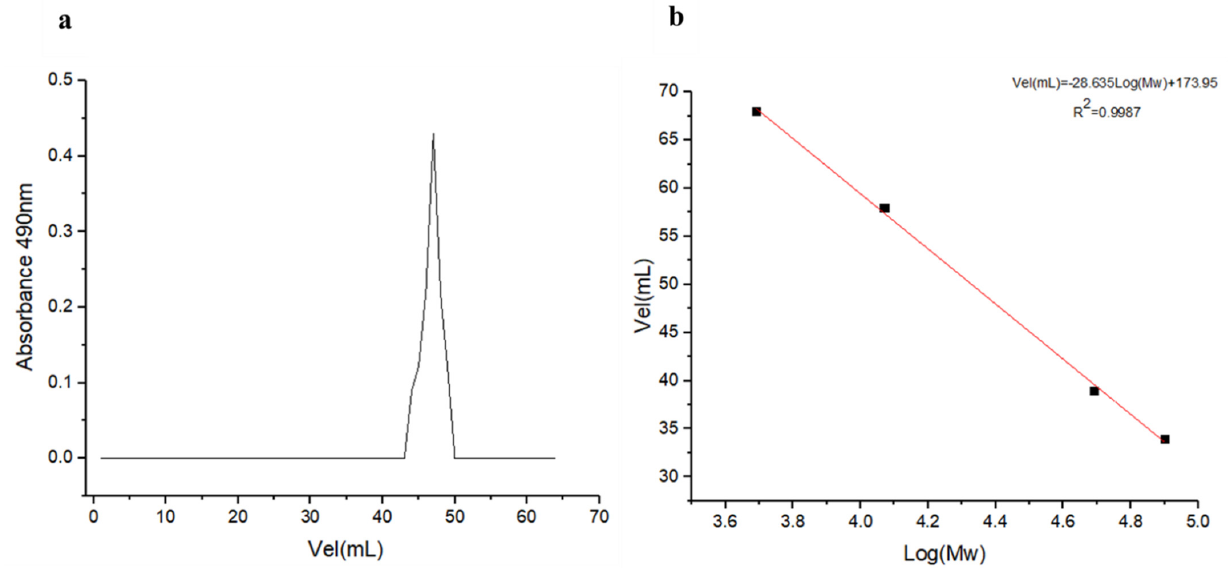
Figure 2. Molecular weight estimation for EPS t. ( a ) Elution curve of EPS t by Sephadex G − 100 gel filtration. ( b ) Standard curve of the relative molecular weight (Mw).